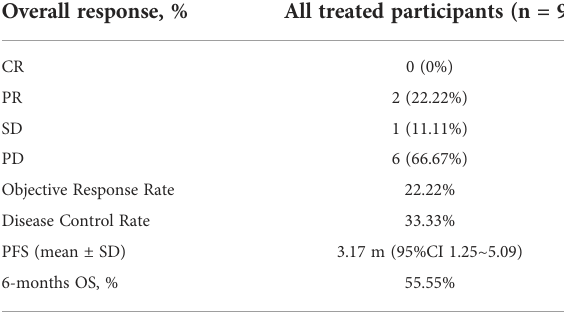
TABLE 2 Best response to treatment according to RECIST